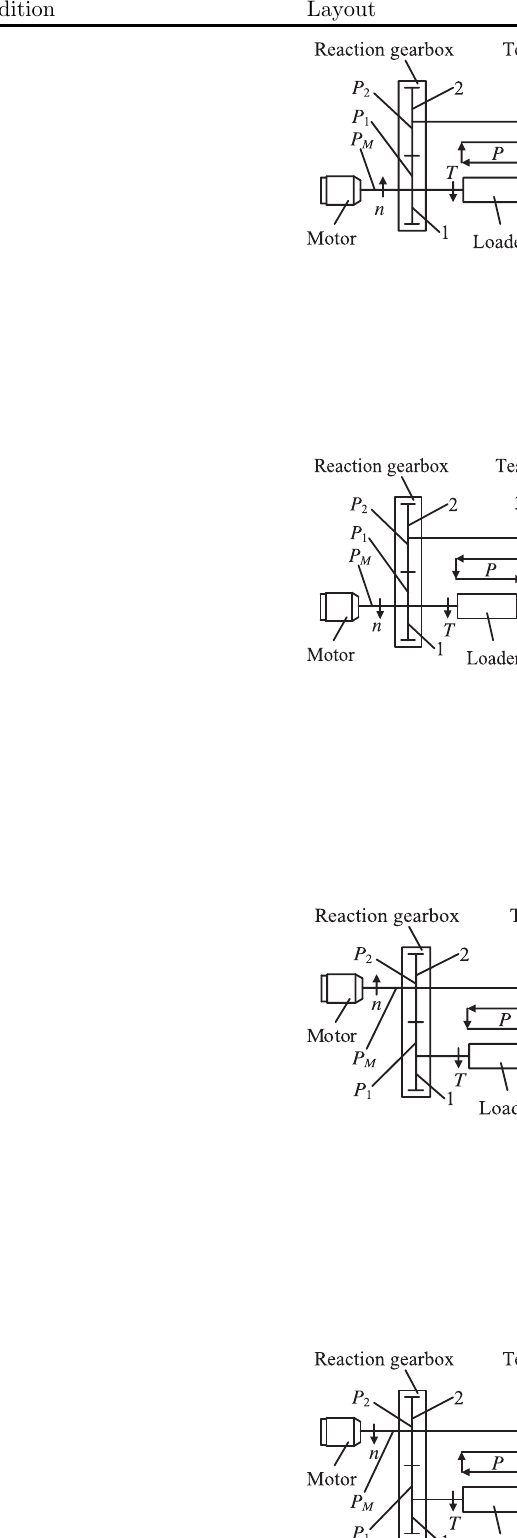
ffiffiffiffiffiffiffiffiffiffiffiffiffiffiffiffiffiffiffiffiffiffiffiffiffiffiffi